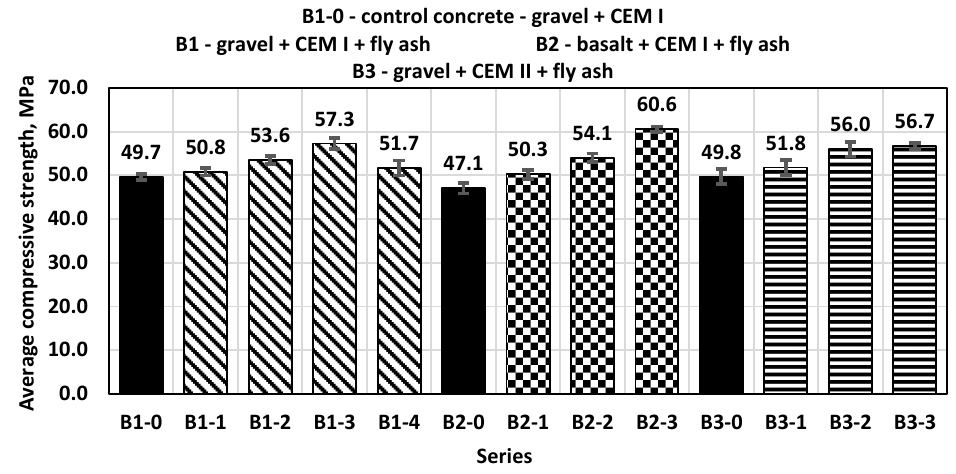
Figure 4. Average compressive strength after 28 days.